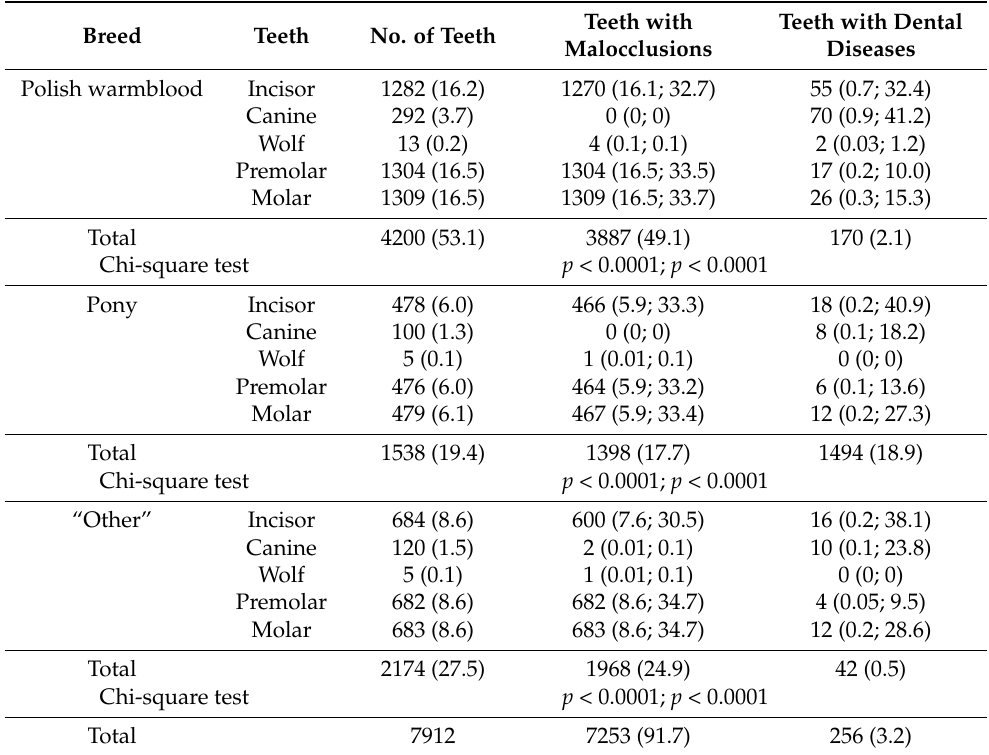
Teeth with Teeth with Dental Malocclusions Diseases